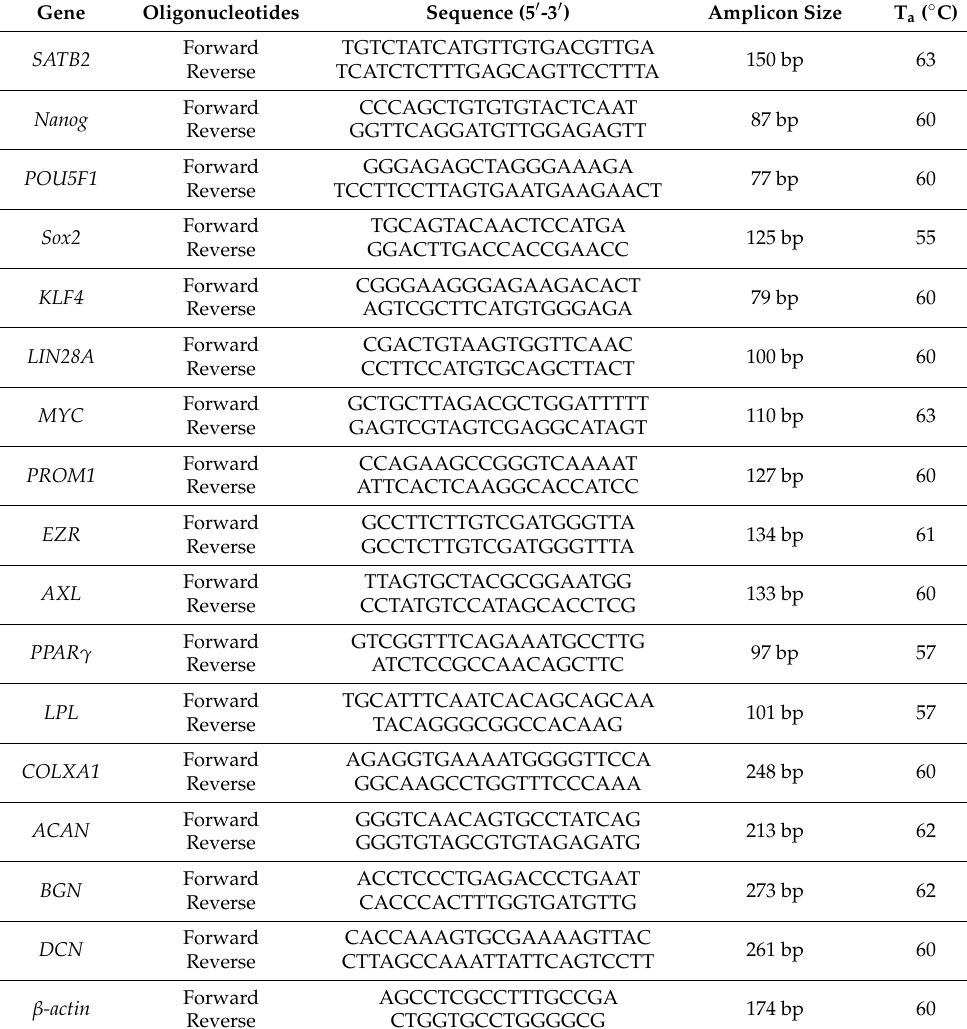
Table 1. Detailed list of primer sequences, with the amplicon size and annealing